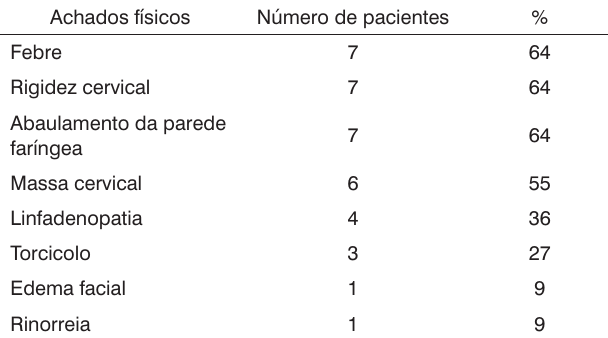
Tabela 2. Achados físicos à